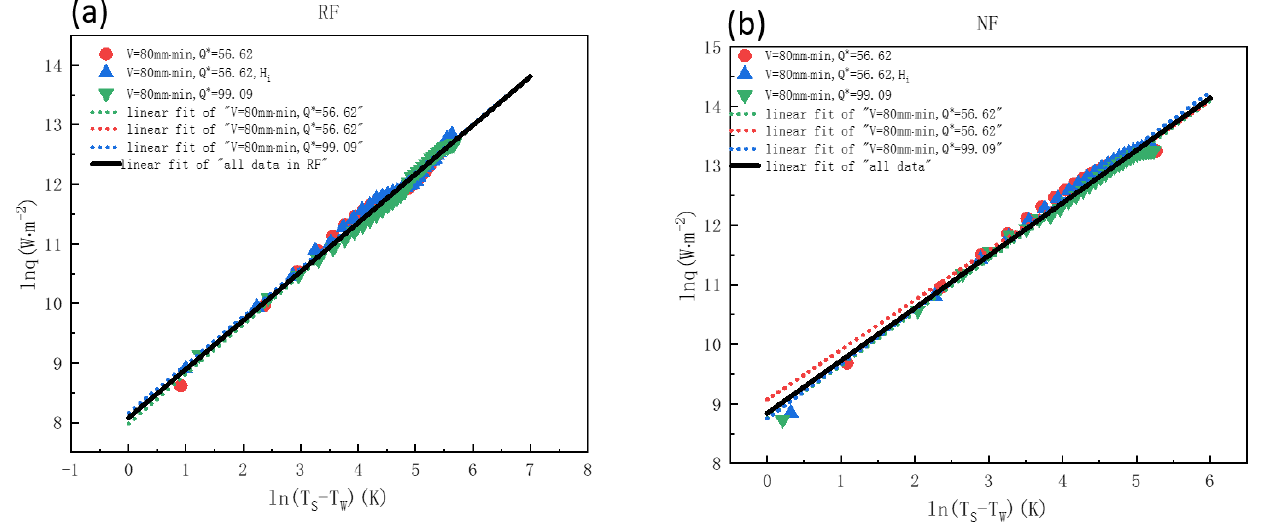
Figure 13. Correlation between data calculated by Equations (22) and (23) and the data gained by DC casting temperature-measurement test: ( a ) at RF ; ( b ) at NF .